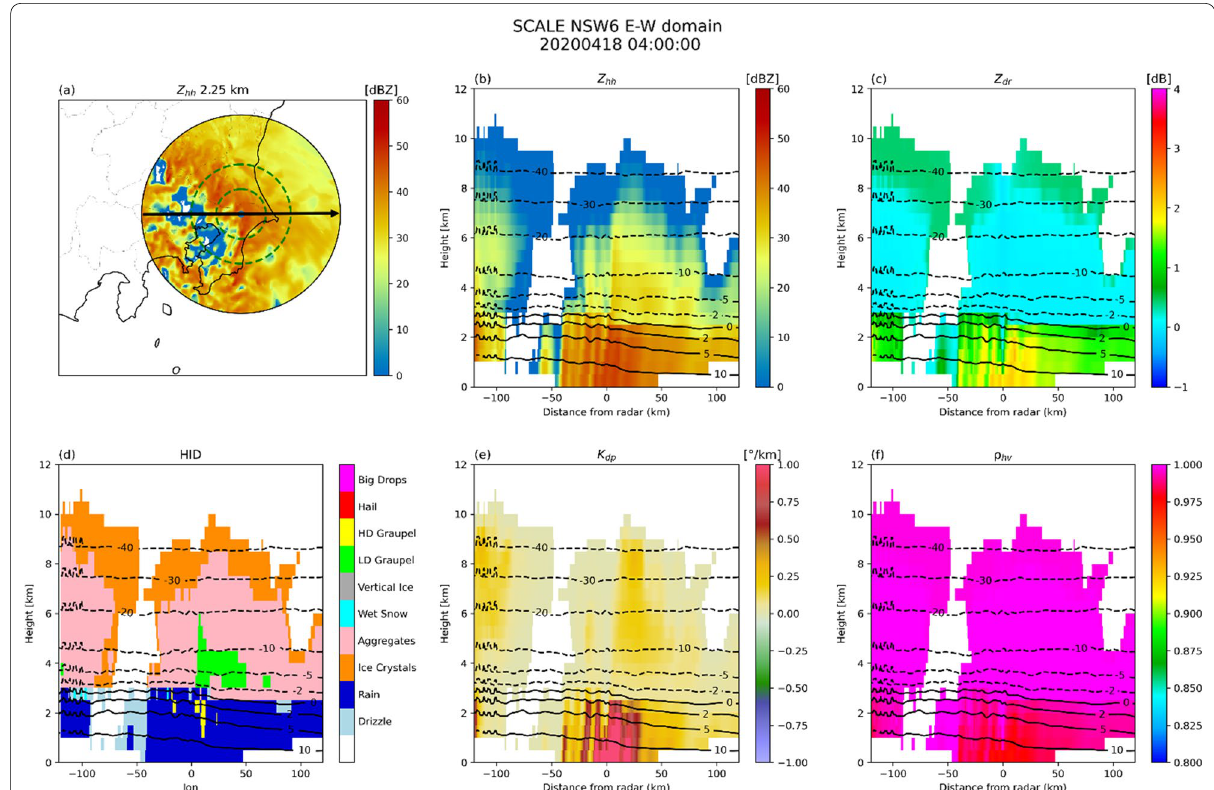
Fig. 20 The same as Fig. 7, but for the SCALE-NSW6